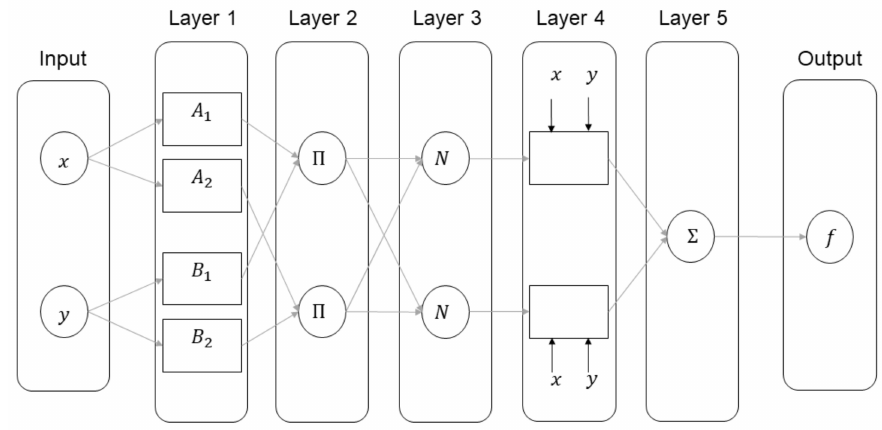
Figure 2. The basic structure of the Adaptive Neural-based Fuzzy Inference System (ANFIS)